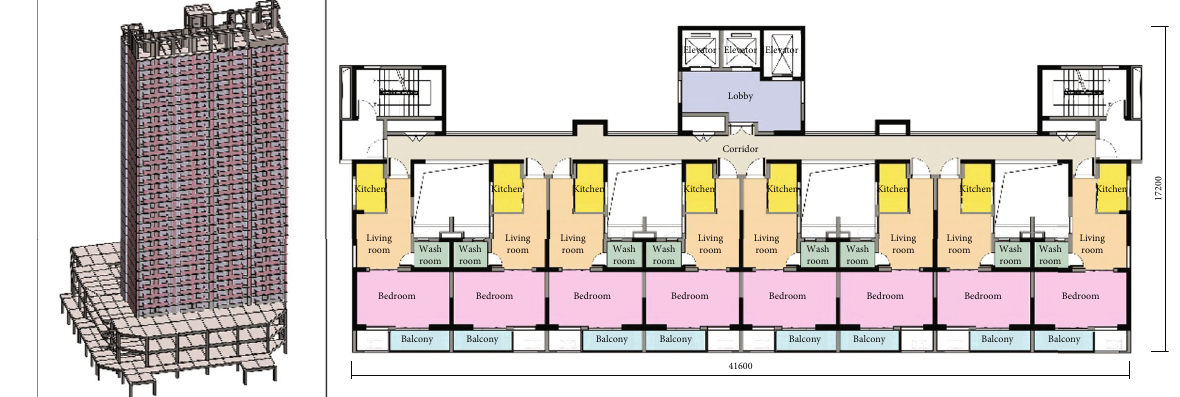
Figure 2: The three-dimensional view and plan of typical fl oor.